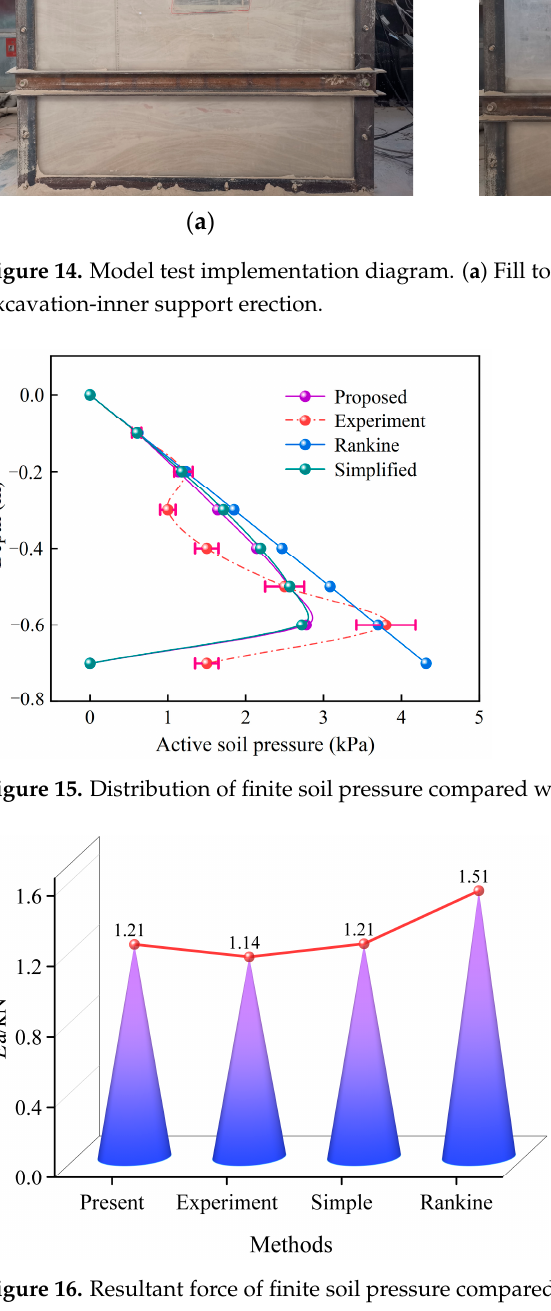
Figure 14. Model test implementation diagram. ( a ) Fill to enclosure structure top elevation, ( b ) Soil excavation-inner support erection.